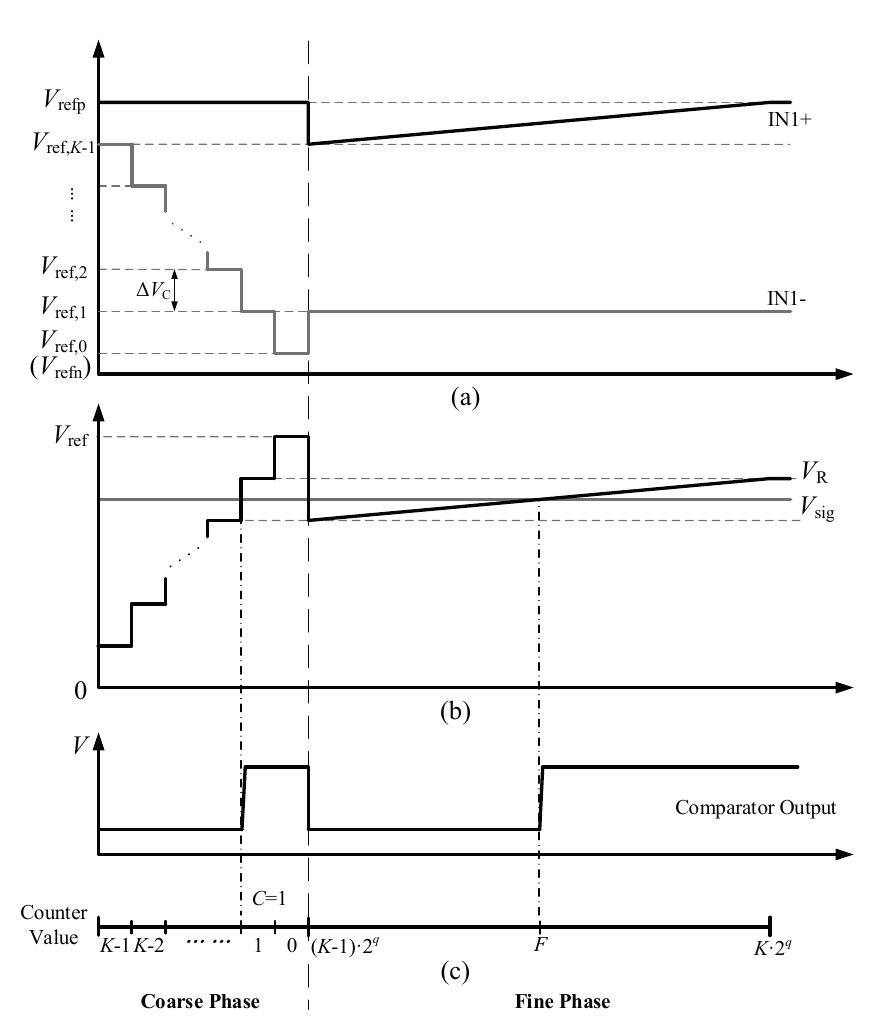
Figure 3. Timing diagram of the proposed two-step SS ADC. Waveforms of ( a ) the IN1+ and IN1 − terminals of the comparator; ( b ) the differential voltages V R and V sig ; ( c ) the comparator